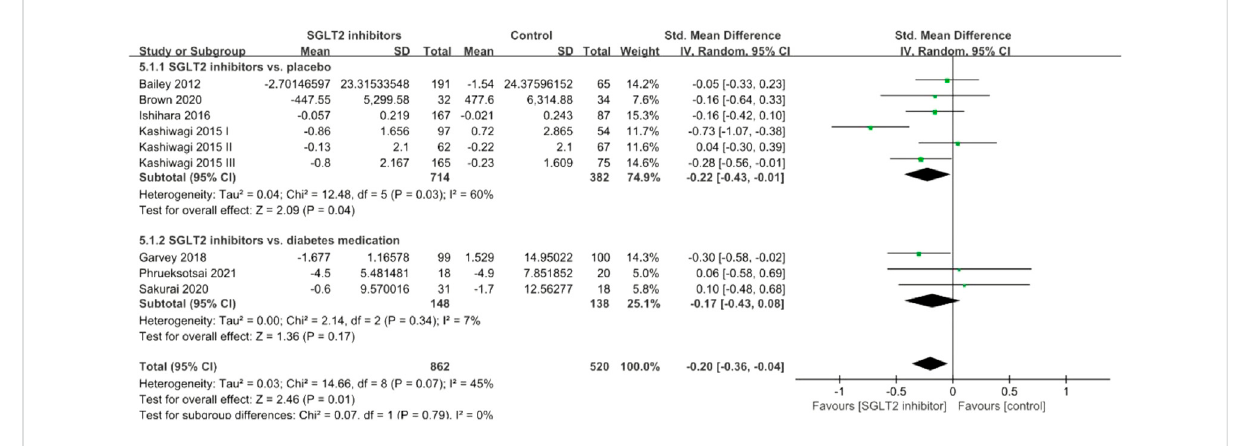
FIGURE 7 Forest plot of the effects of SGLT2 inhibitors on leptin.